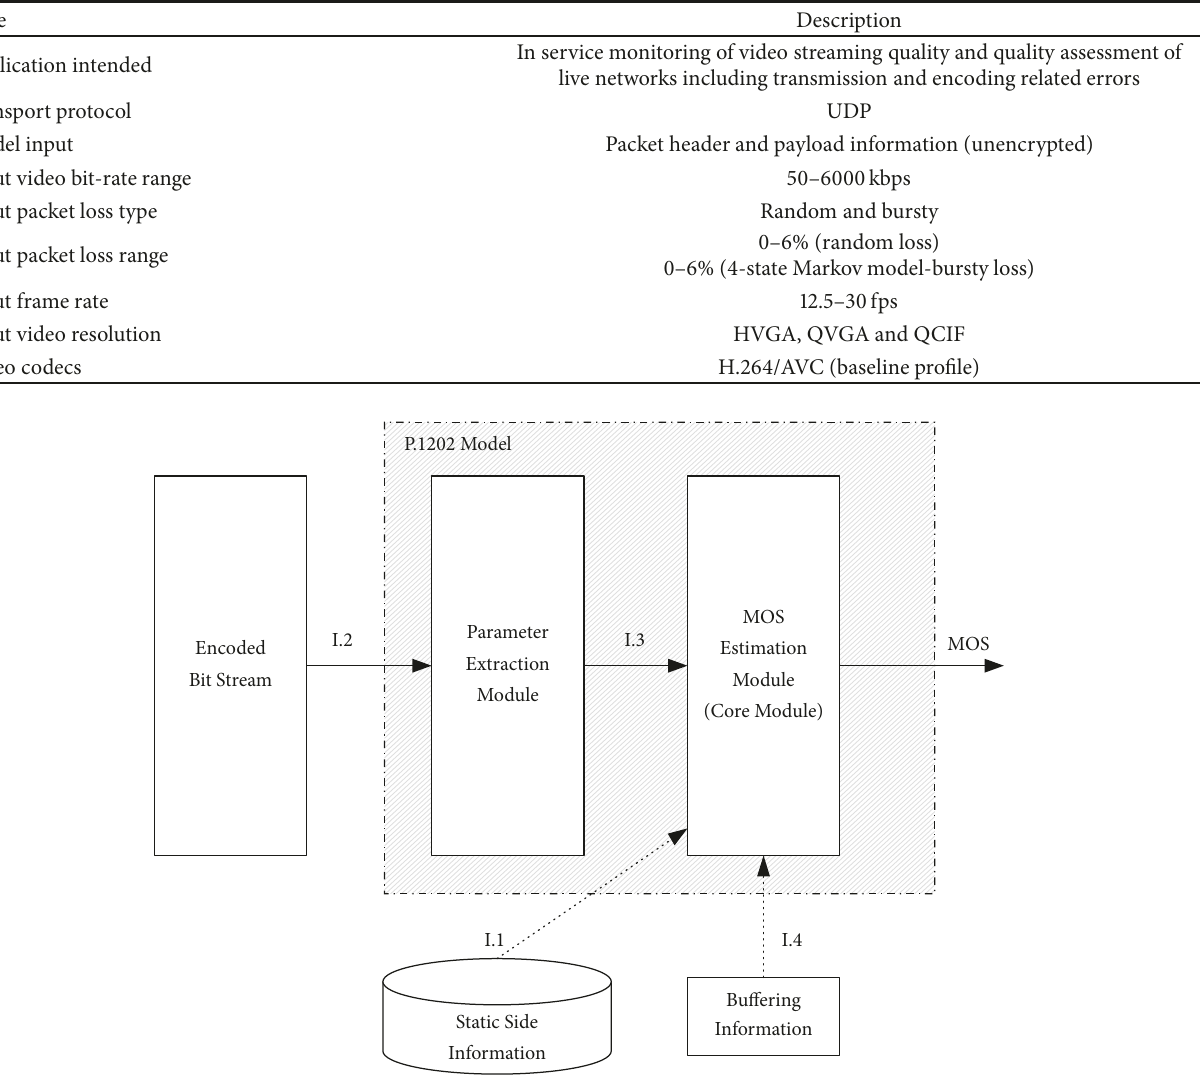
Figure 21: Overview of ITU-P.1202 model